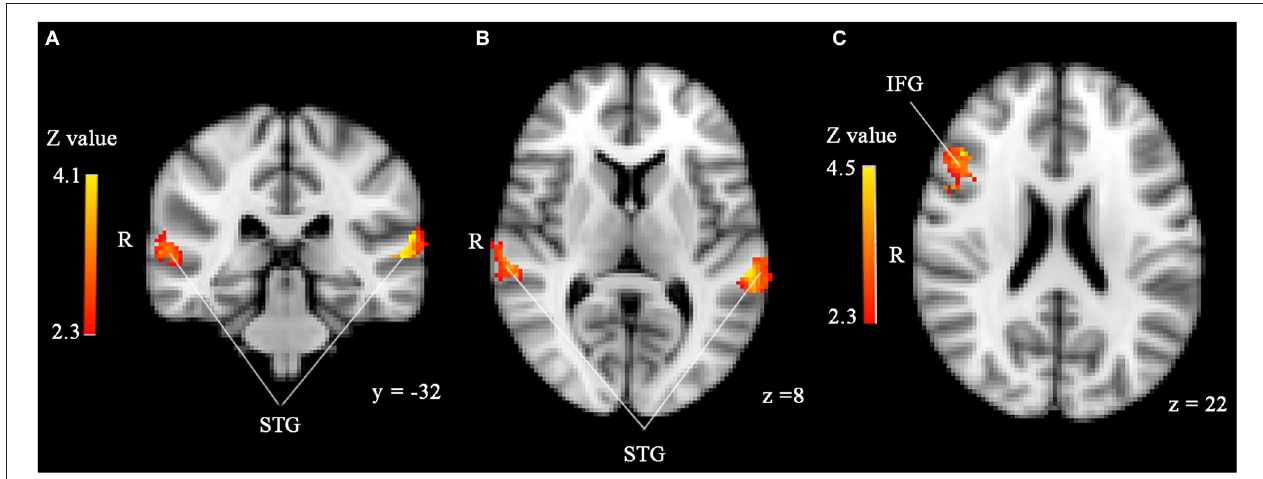
FIGURE 1 | (A,B) Significantly enhanced activity in bilateral superior temporal gyrus (STG) in response to unfamiliar compared to familiar faces in the sample with 45 participants. (C) Significantly enhanced activity in right inferior frontal gyrus (IFG) in response to familiar compared to unfamiliar faces. ROI analyses, p < 0.05, corrected by cluster threshold ( Z >